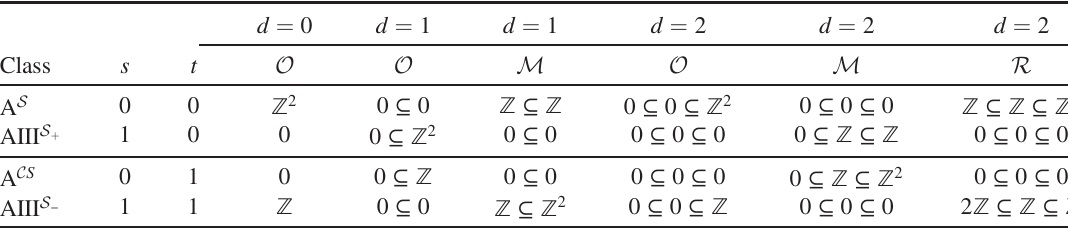
TABLE II. Bulk classification sequence K ð d Þ ⊆ (cid:3) (cid:3) (cid:3) ⊆ K 0 ⊆ K for zero- ( d ¼ 0 ), one- ( d ¼ 1 ), and two- dimensional ( d ¼ 2 ) typological crystalline insulators and superconductors with an order-two crystalline symmetry or antisymmetry for the complex tenfold-way classes. The symbols O , M , and R refer to a local on-site ( d mirror ( d ¼ 1 ), and twofold rotation symmetry ( d ¼ 2 ), respectively. k k